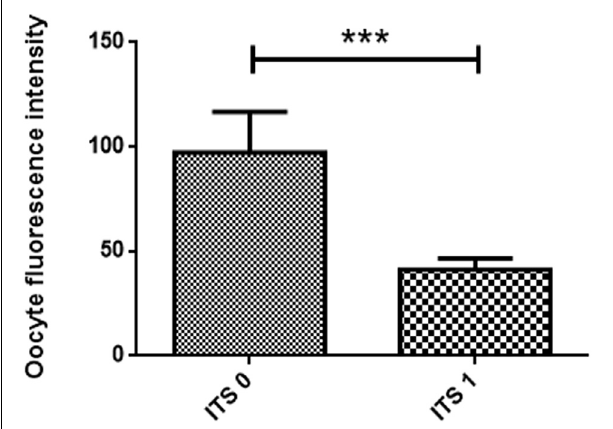
FIGURE 3 | Effect of insulin-transferrin-selenium (ITS) on oocyte reactive oxygen species level. Data show mean ± SEM. Oocyte fluorescence intensity (transmittance) in each experimental group after staining with 2 (cid:48) ,7 (cid:48) -dichlorodihydrofluorescein diacetate (three replicates). ITS 0: oocytes matured in the absence of ITS; ITS 1: oocytes matured in the presence of 1 µ l/ml of ITS. The meaning of “***” is that the statistical difference is significant.